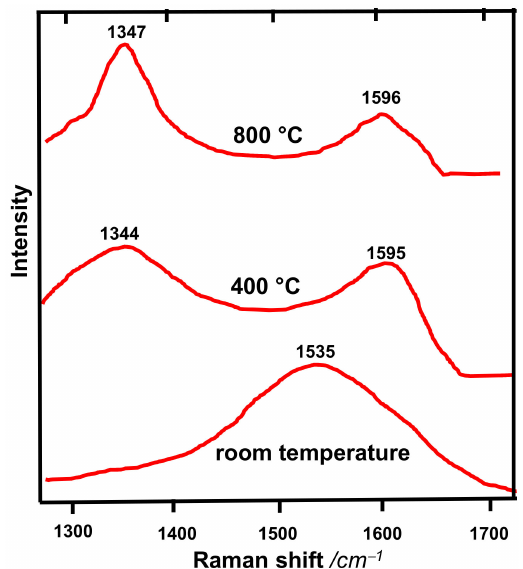
Figure 6. Raman spectrum of carbon films deposited by MSIBD at various temperatures (data from